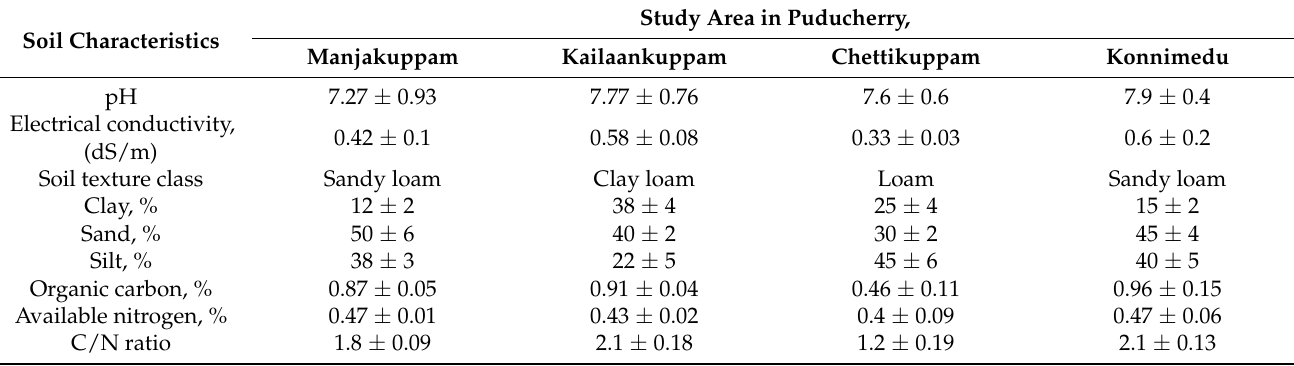
Table 1. Soil physico–chemical properties of the experimental